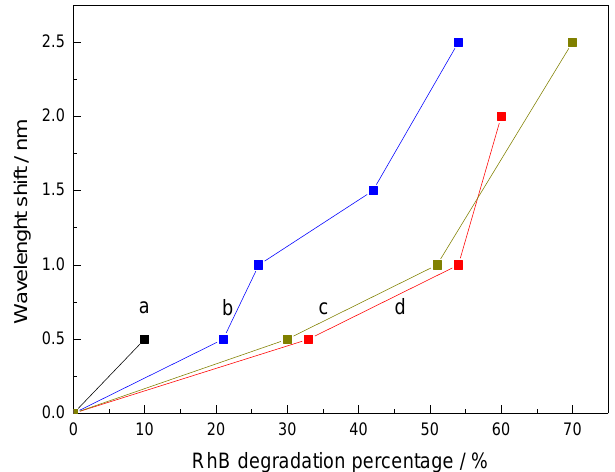
Figure 6. The maximum absorption wavelength shift ( λ max = 554 nm) of RhB as a function of degra- dation percentage in the presence of BTO ( a ), BTO_2 ( b ), BTO_3 ( c ), and BTO_1 ( d ) photocatalysts during 360 min of irradiation.